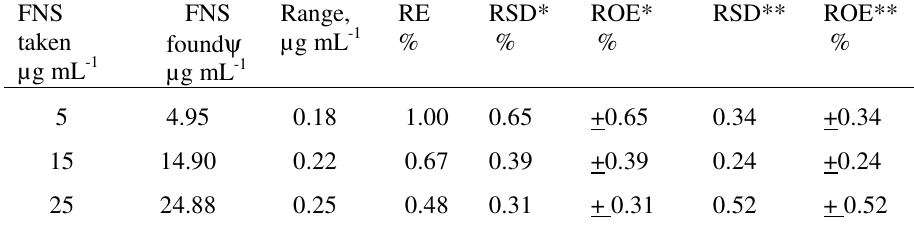
Table 2. Evaluation of accuracy and